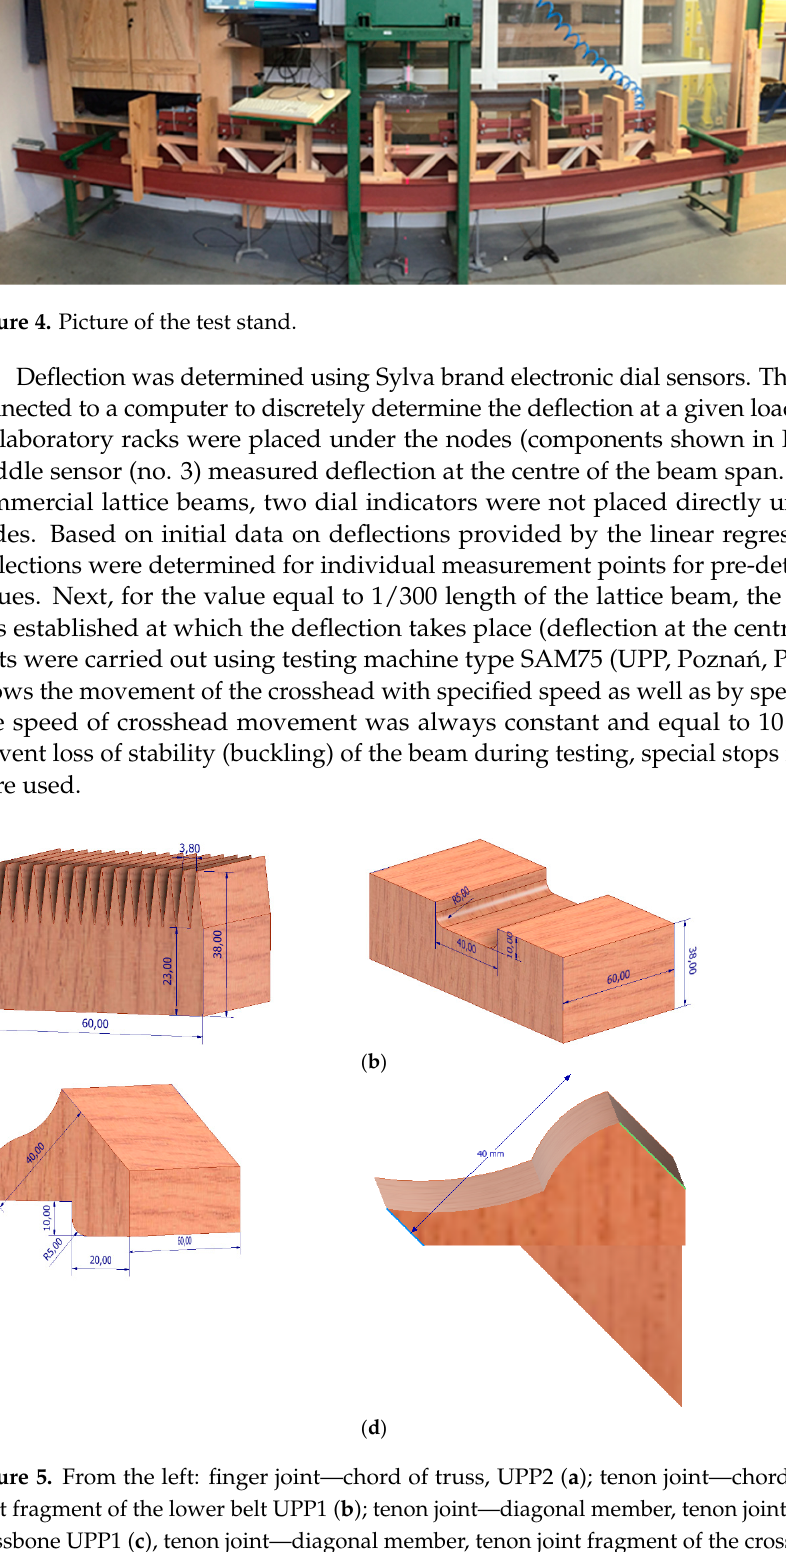
Figure 3. Truss loading diagram at two distinguished nodes (P 1 = P 2 =11.12 kN )—scheme B.